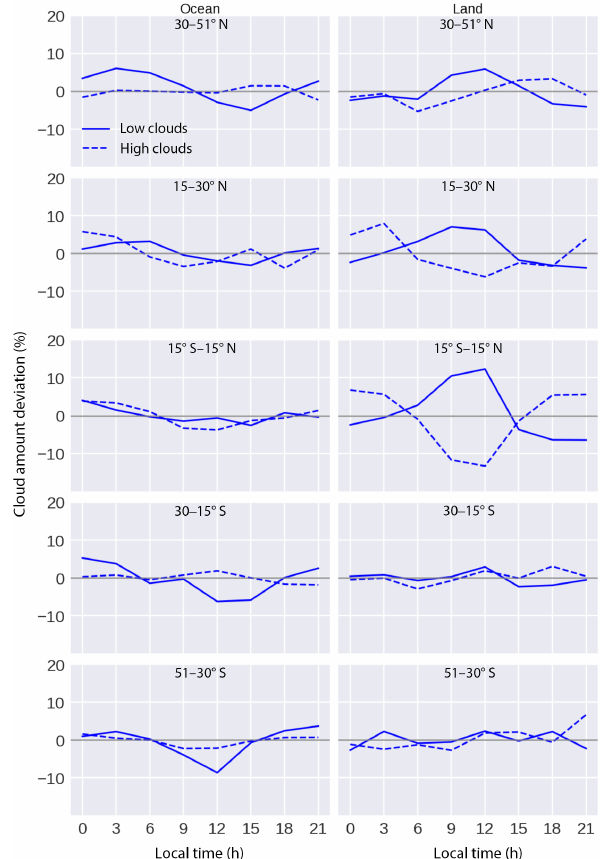
Figure 6. Mean diurnal variations of low-level (solid line) and high- level (dotted line) cloud amounts (%) every 3h in five zonal bands over ocean (left) and land (right) in JJA from CATS for the period